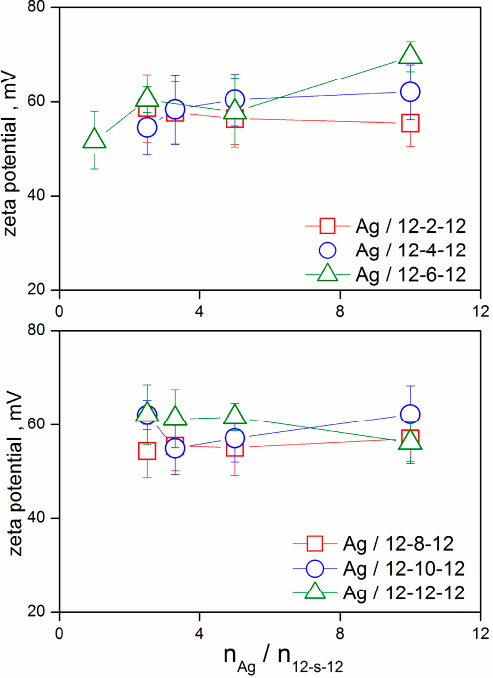
Figure 9. Zeta potential of silver nanoparticles stabilized with gemini surfactants 12- s -12 as a function of n Ag /n 12- s -12 .